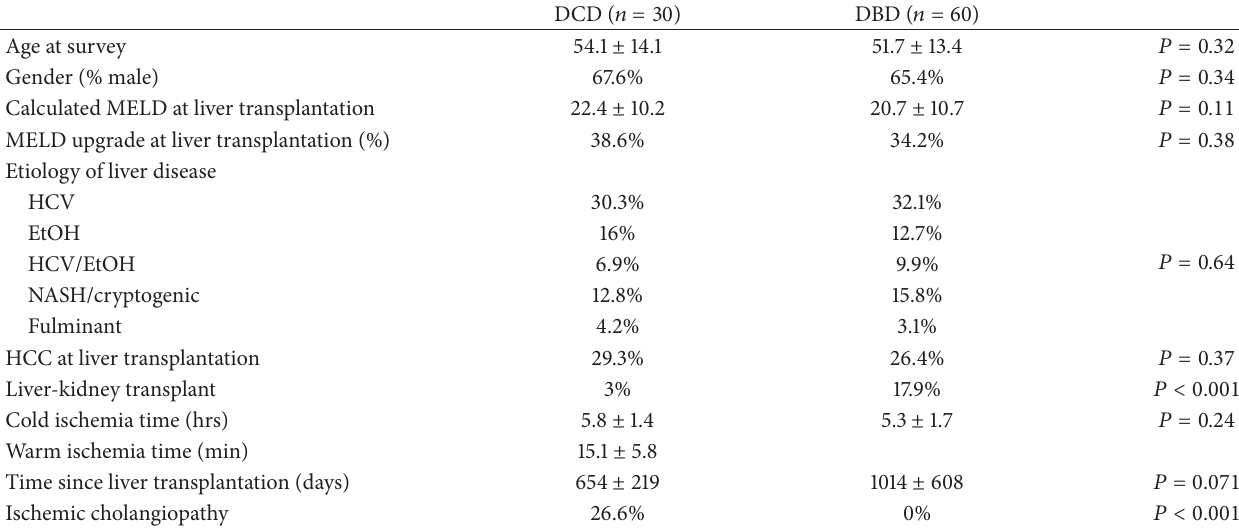
Table 2: Baseline characteristics of liver transplant recipients with a quality of life assessment.